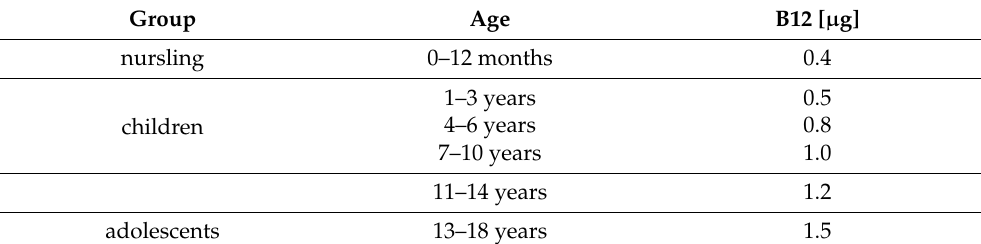
Table 1. Recommended daily intake of vitamin B12 according to age groups.